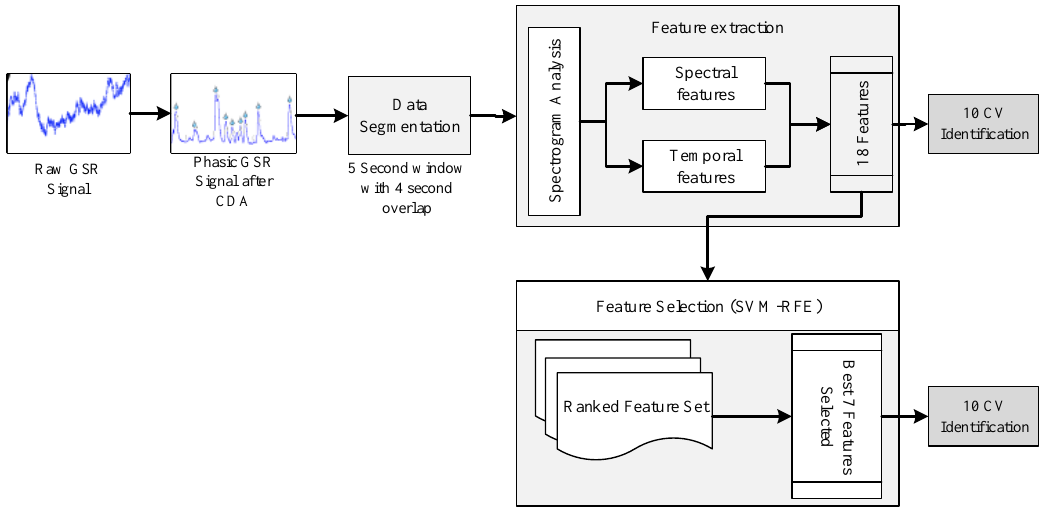
Figure 1. Flowchart of the proposed driver monitoring and intervention system on the edge. Galvanic Skin Responses (GSR); Continuous Decomposition Analysis (CDA); 10-fold Cross Validation (10-CV); Support Vector Machine Recursive Feature Elimination